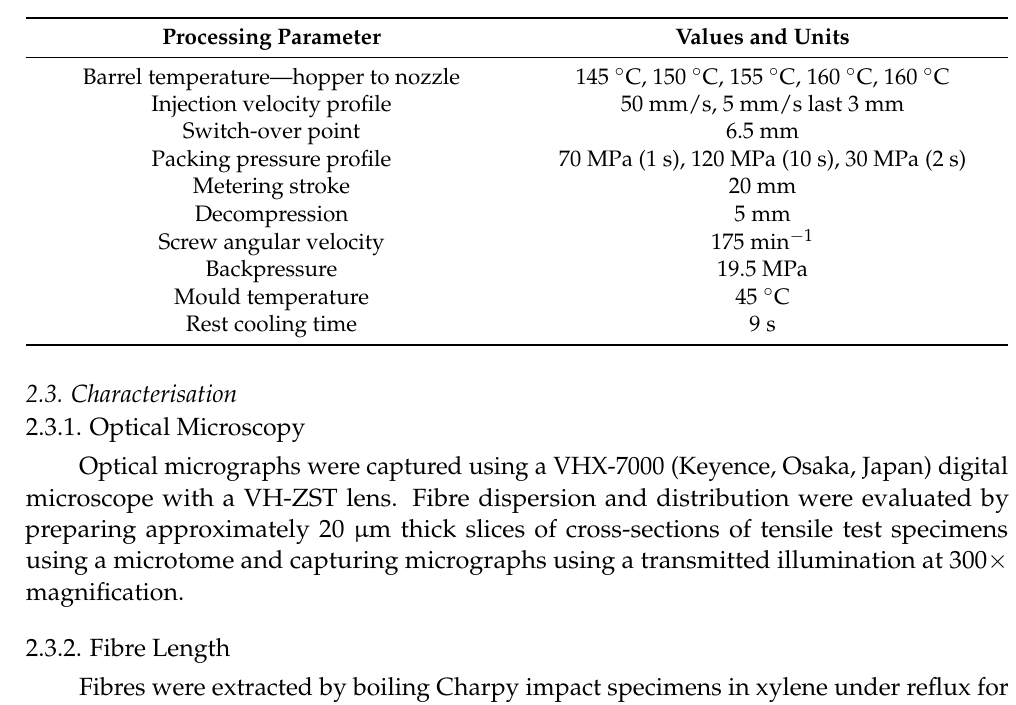
Table 4. Injection moulding processing